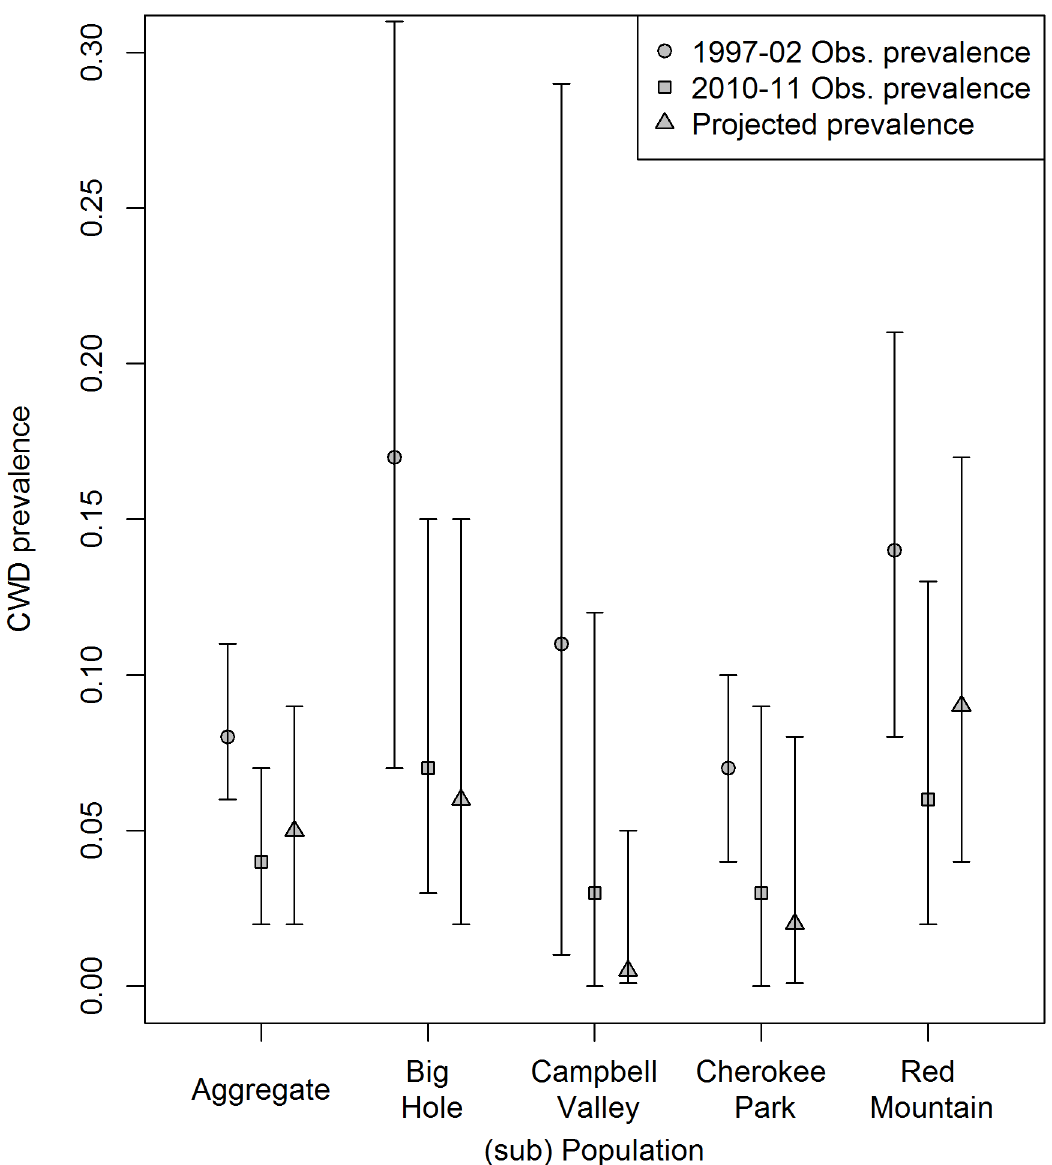
Fig 6. Forecasted CWD prevalence – compared to historic and recent CWD prevalence. Posterior estimates (mean and 95% equal-tailed credible intervals) of CWD prevalence during surveillance efforts during 1997 – 2002, capture-recapture studied deer at the time of entry into study, and forecasted short-term prevalence assuming survival, fertility, and infection conditions remained as we measured them during 2010 – 14. Prevalence was estimated from female deer > 1 year of